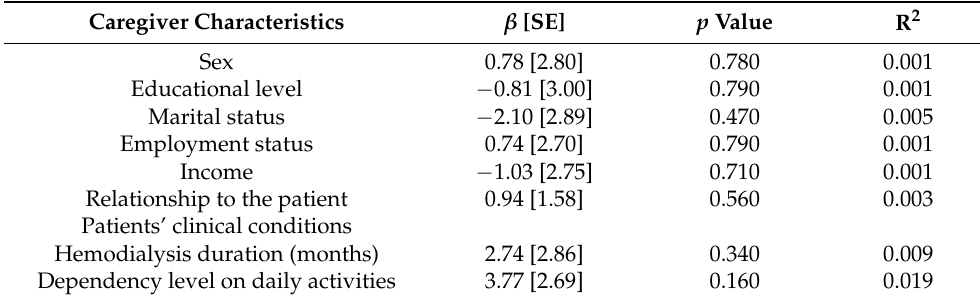
Table 3. Simple linear regression between sociodemographic and clinical-condition variables and